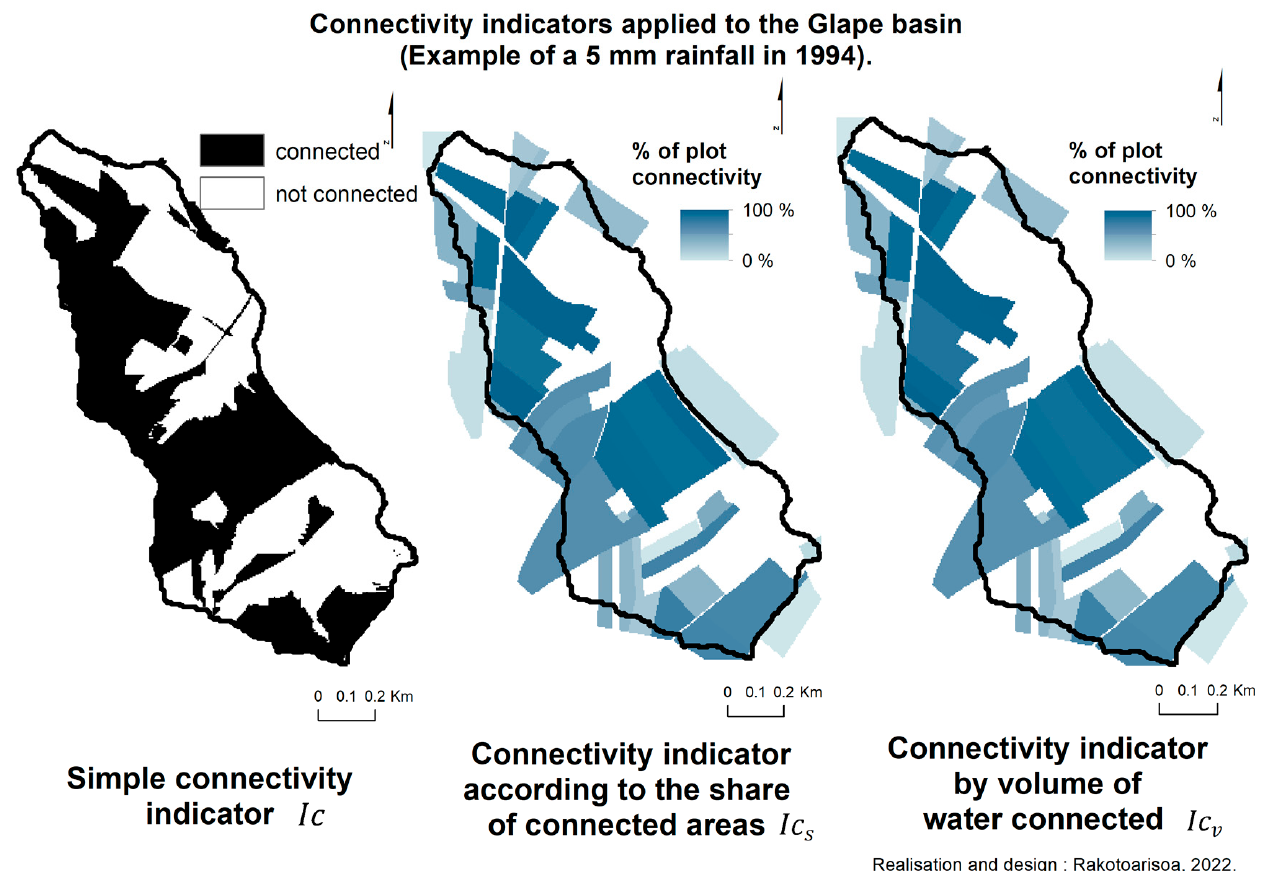
Figure 7. Connectivity indicators applied to the Glape basin.